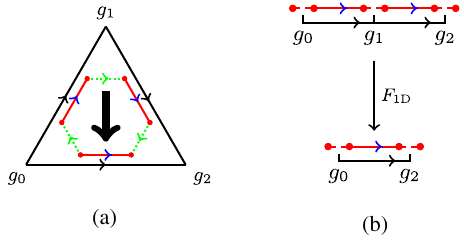
FIG. 7. Relation between FSLU U 1 for a 2D triangle and 1D F move. The 2D triangle can be viewed as a 1D F move from the upper two links to the lower link. It relates the trivialization of 2D n 2 data to the obstruction of a 1D Kitaev chain. (a) The FSLU transformation U 1 in Eq. (160) for a single triangle. This FSLU changes the fermion parities of the Majorana fermions and the ¯01 ; ¯23 Þ and ð − 1 Þ n 2 ð 012 Þ , respectively. complex fermions by ð − 1 Þ ω 2 ð (b) The 1D F move Eq. (164) for the boundary ASPT state. This F move changes the fermion parities of the Majorana fermions ¯01 ; ¯23 Þ and the complex fermions by ð − 1 Þ ω 2 ð and ð − 1 Þ n 2 ð 012 Þ ,